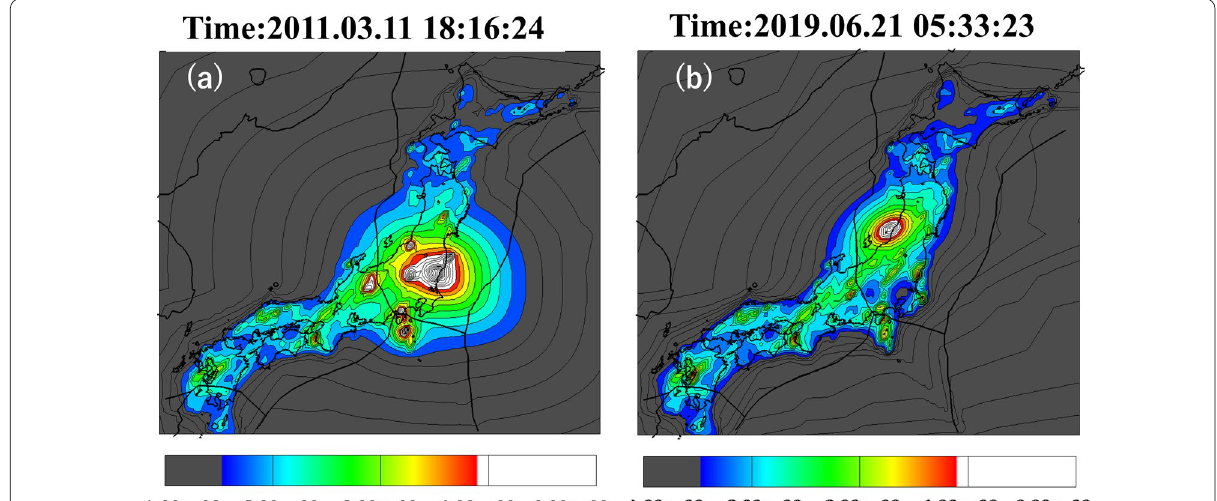
Fig. 2 Snapshots of the optimal maximum a posteriori (MAP) conditional intensity function in Eq. (3) at the dates and times listed at the top for the HIST–ETAS–5pa model in a learning period 1885–2018 and b forecasting period starting from 2019 to September 2021. Contours in both images are presented with the common equidistant intervals in logarithmic scale. The color bars below the images represent the occurrence rate of a M 4.0 event per 1.0° 1.0° cell per day on the ordinary logarithmic ≥ ×